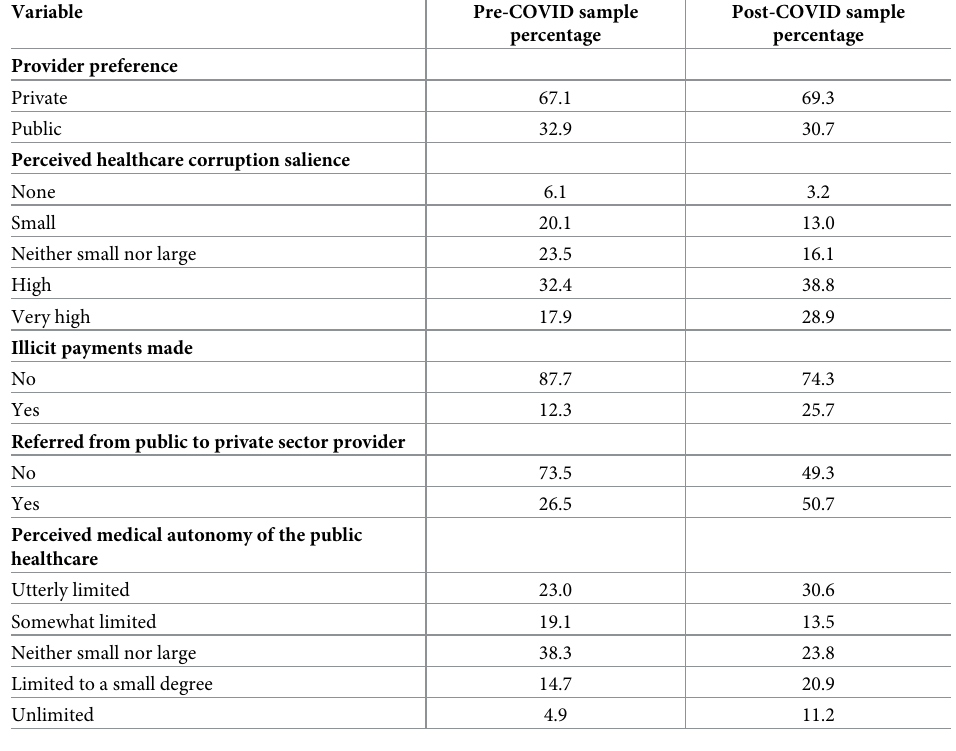
Table 2. Public trust and perceived corruption in Montenegrin public healthcare in pre-COVID and post-COVID surveys.